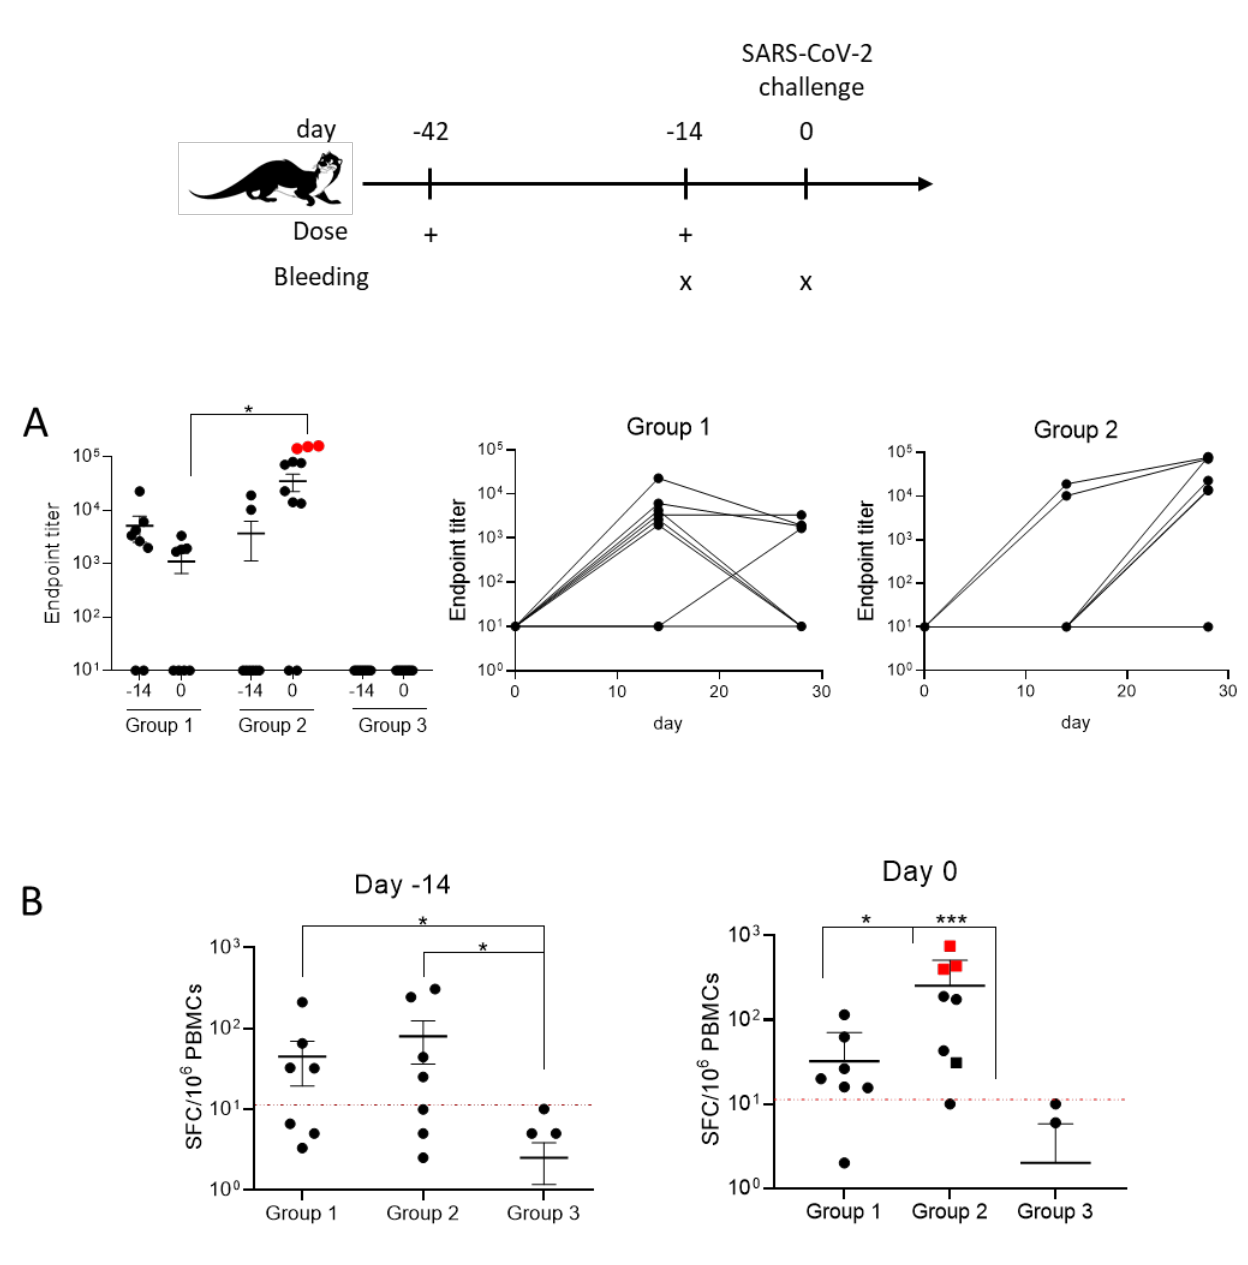
Figure 1. Immune responses induced by COVID- e Vax. Groups of ferrets ( n = 8) were vaccinated with one dose on day 42 (one dose, group 1), with a second dose on day 14 (two doses, group 2), or left untreated (Group 3). Sera and PBMCs were collected on day 14 and day 0 before DNA vaccination. ( A ) Endpoint titer values of binding antibody measured by ELISA at day 0, and antibody titers over time. ( B ) T-cell responses measured by ELISpot assay. PBMCs were stimulated with the RBD peptide pool as described in the Materials and Methods. IFN- γ -producing spot-forming colonies (SFCs) were counted, and DMSO values were subtracted; animals in group 3 with values below 1 are not reported in the logarithmic scale. Values in red are from the animals in group 2 with viral RNA below the LLOQ in Figure 2. Mann–Whitney tests were conducted: * p < 0.05, *** p < 0.005.